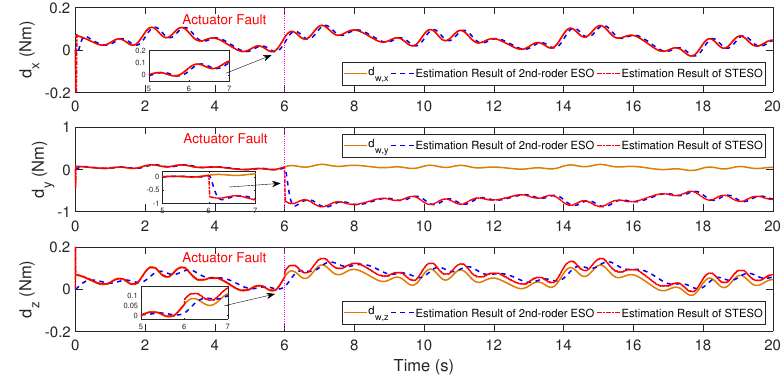
Figure 6. Disturbance estimation results in Case A.